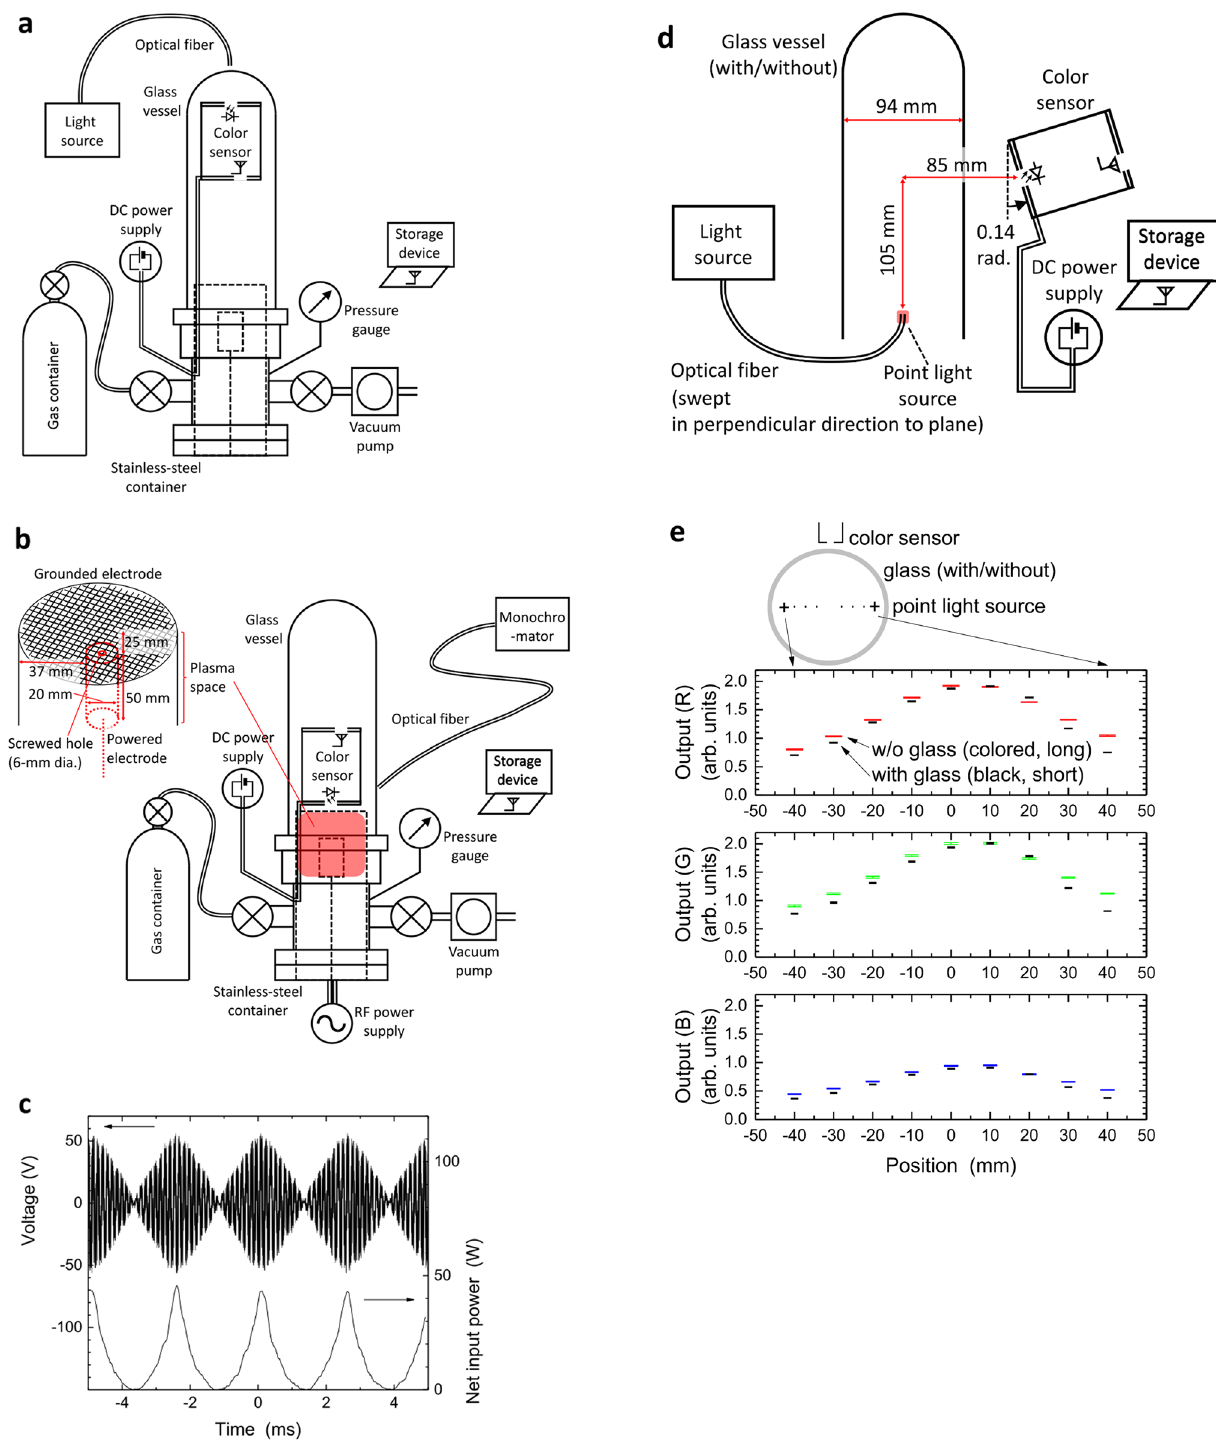
Figure 5. Setups of the vacuum chamber with colour sensor installation. (a) Detection of externally-controlled light. The data in Fig. 2 are obtained in this setup. (b) Detection of Ar plasma emissions. The data in Fig. 3 are obtained from this setup. (c) Example time evolutions of radiofrequency signals: forward voltage monitored by a directional coupler located before the powered electrode (upper side) and net input power (lower side). (d) Identification of the difference between direct (without glass) and indirect (with glass) sensing. (e) Colour sensor signals in direct and indirect measurements in the setup shown in (d)